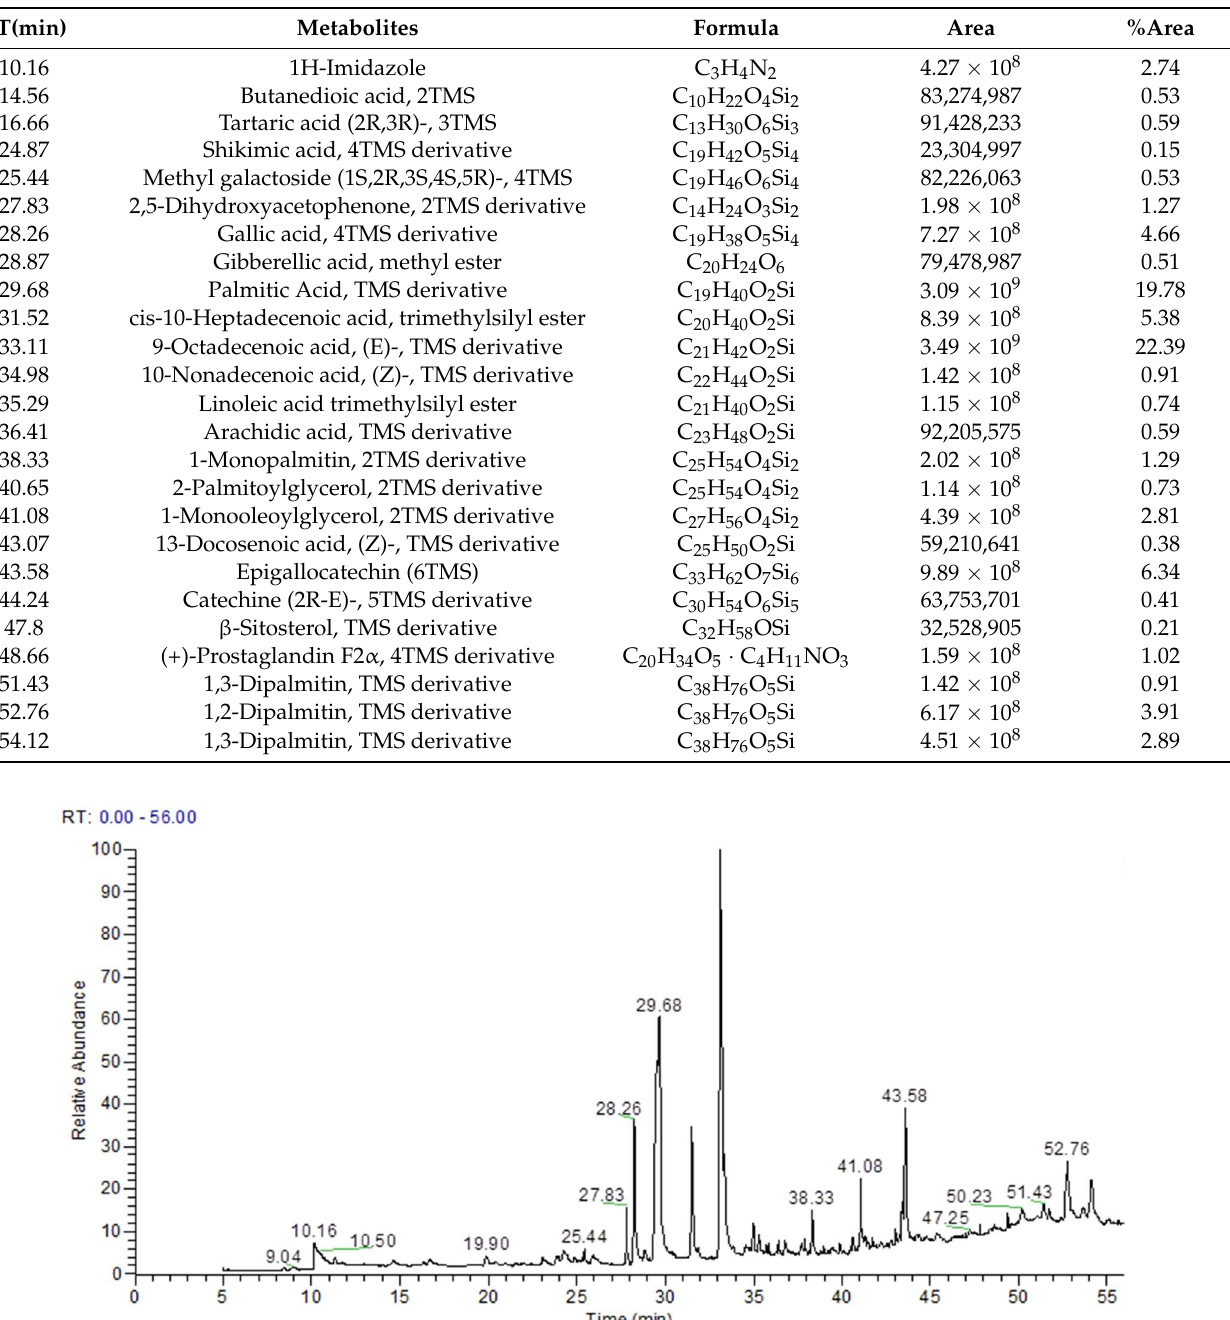
Table 1. Phytocompounds identified in bioactive fraction of A. acuminata leaf extract.